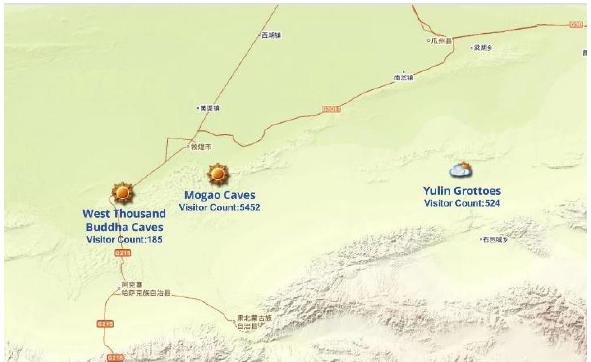
Figure 6. The real-time monitoring data view Base Map Source: © Tianditu